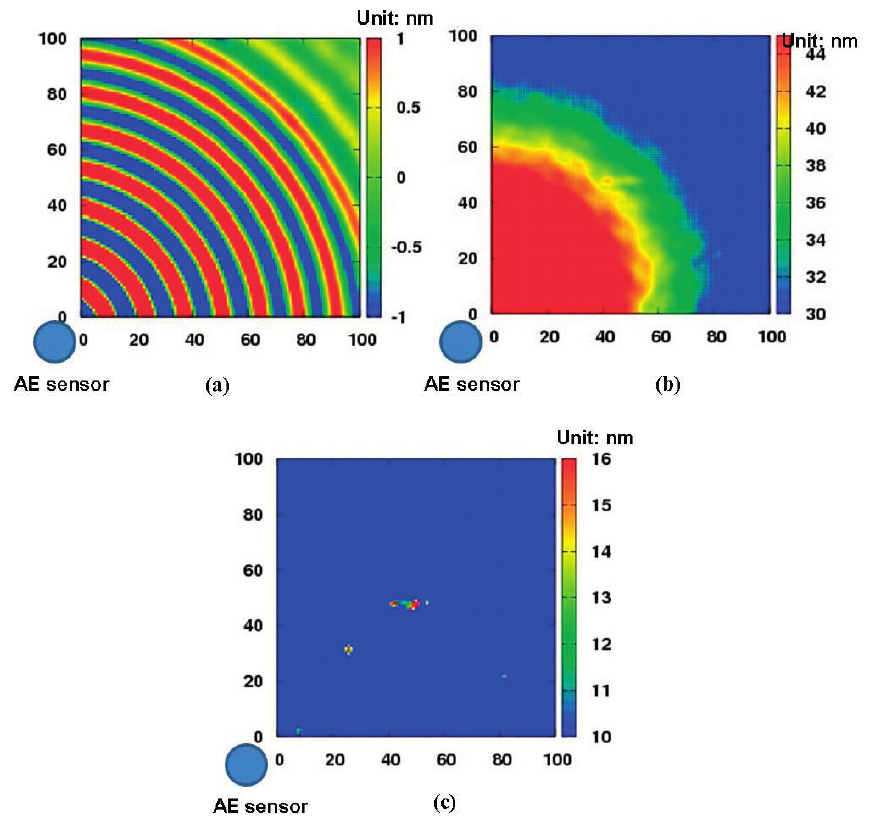
Figure 8. Diagnostic images a 0.2 mm depth non-penetrative slit: ( a ) snapshot at 100 µs; ( b ) distribution image of kinetic energy; ( c ) the improved diagnostic